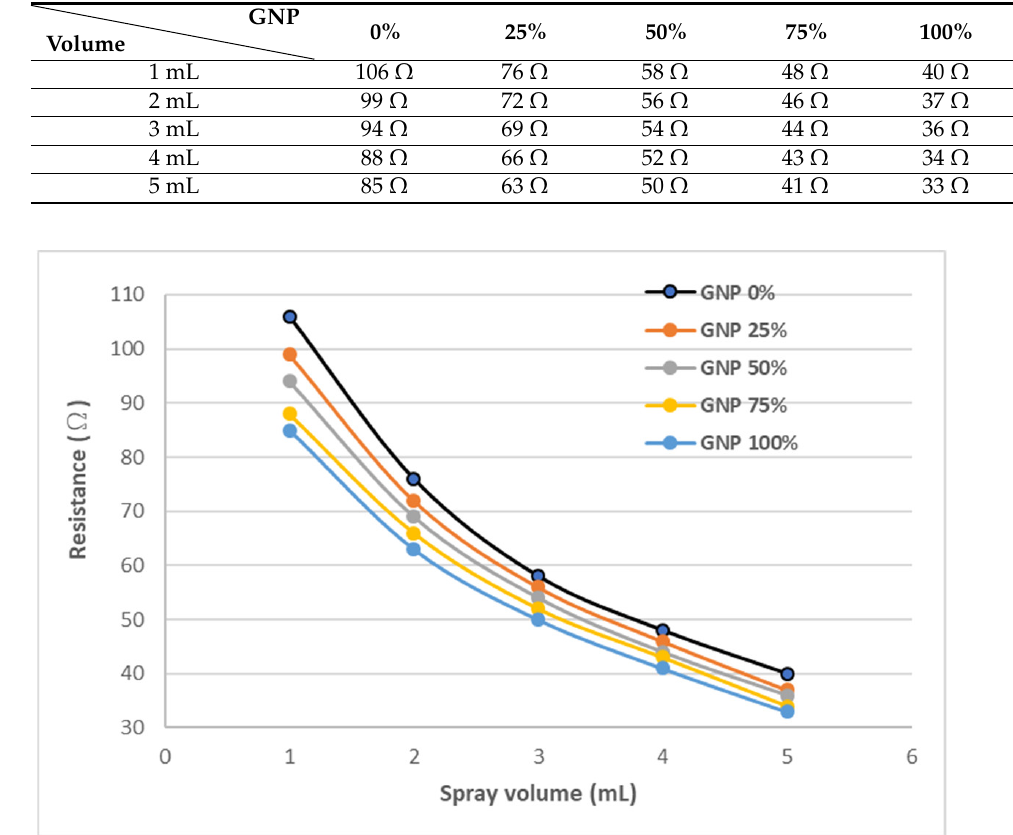
Figure 7. Resistance of hybrid nanomaterial film varying with spray volumes and GNP contents. The test specimen, as shown in Figure 3, was placed in a universal test machine and subjected to a tensile loading. The electrical resistance of the nanocomposite film was measured by a source meter. The resistance changes of the nanomaterial film as a function of applied strain were recorded. Figure 8 plots the resistance change vs. applied strain of the nanomaterial films with spray volume varying from 1 mL to 5 mL on the PI substrate, while the GNP content was kept at a constant of 50 wt.%. The resistance change follows closely and monotonically with the applied strain. A good linearity between the resistance change and applied strain with the coefficient of determination greater than 0.99 depicts the feasibility of the nanomaterial film as a strain sensor. The slopes of the linear